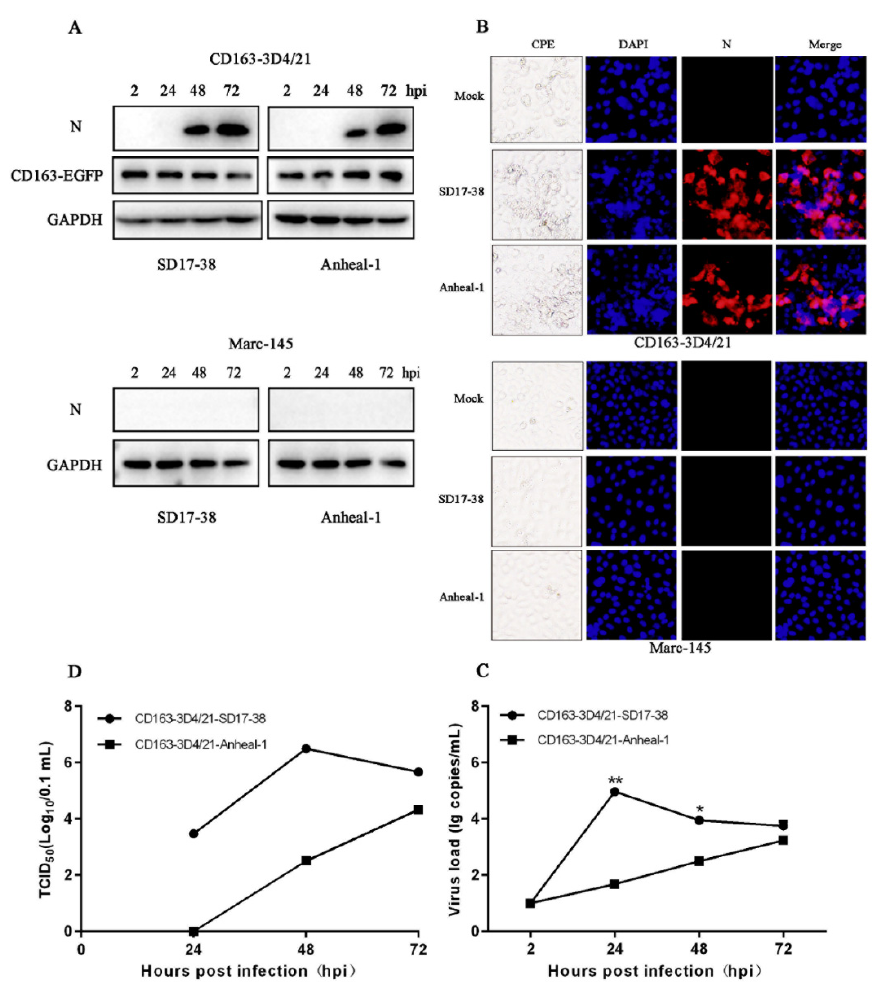
Figure 5. CD163-3D4/21 cells are able to be infected by NADC30-like and NADC34-like PRRSV2 strains. ( A ) The CD163-3D4/21 cells and MARC-145 cells seeded in 24-well plates were infected with NADC30-like SD17-38 and NADC34-like Anheal-1, at an MOI of 0.1, for the indicated time points, followed by Western blotting. ( B ) The infected cells were observed for CPE, and fixed at 48 hpi followed by IFA using PRRSV N specific mouse mAb (6A1, 1:500 dilution). ( C ) The ORF6 gene transcriptions of NADC30-like SD17-38 and NADC34-like Anheal-1 were determined by TaqMan real time RT-PCR. ( D ) The viral titers of NADC30-like SD17-38 and NADC34-like Anheal-1 in CD163- 3D4/21 cells were determined by TCID50 assay based on viral N fluorescence signals. * p < 0.05, ** p <